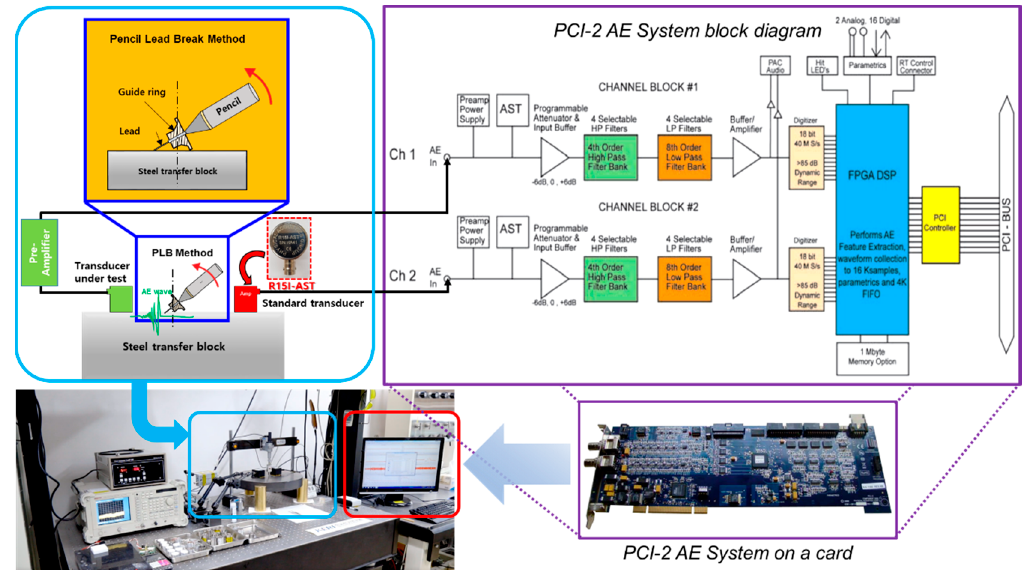
Figure 9. Schematic diagram of measurement system of the AE sensor.